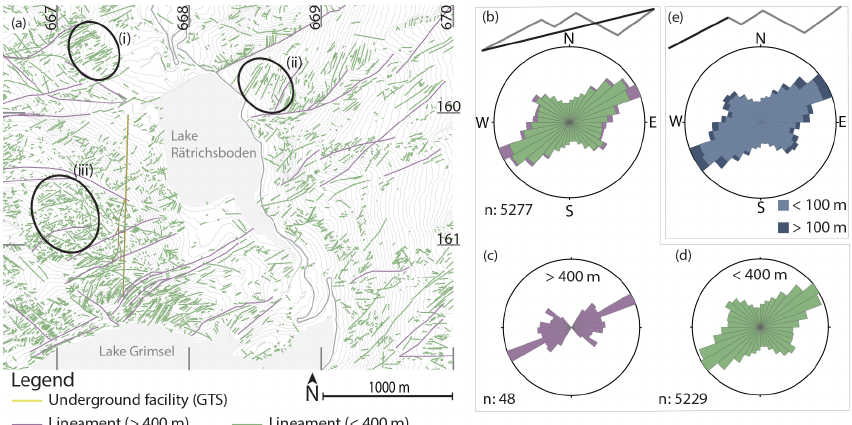
Figure 6. (a) Lineament map of the study area with underground rock laboratory. Topography contours are based on swissALTI3D (re- produced by permission from swisstopo; BA17063). (b) – (d) Length-weighted rose diagrams showing the endpoint-to-endpoint strike of all lineaments (b) , lineaments longer than 400m (c) , and lineaments shorter than 400m (d) . (e) Length-weighted rose diagram showing the orientation of each segment of all